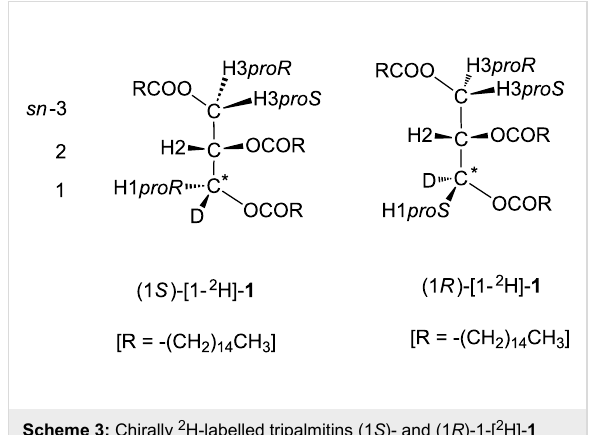
Scheme 3: Chirally 2 H-labelled tripalmitins (1 S )- and (1 R )-1-[ 2 H]- 1